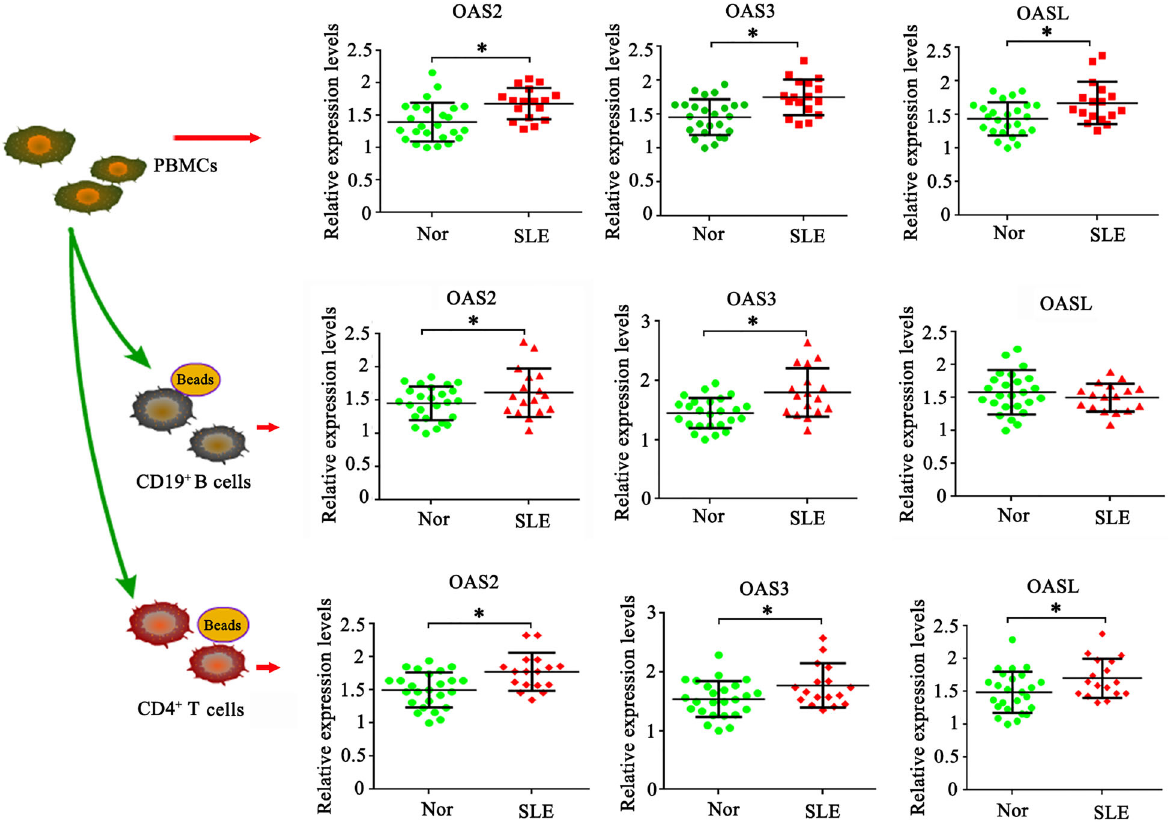
Figure 2. OAS2, OAS3, and OASL were up-regulated in immune cells in systemic lupus erythematosus (SLE) patients. PCR assay was performed to evaluate OAS2, OAS3, and OASL expression in peripheral blood mononuclear cells (PBMCs), CD19 + B cells, and CD4 + T cells in patients with SLE and healthy participants (Nor). Horizontal lines indicate median and interquartile range. *P o 0.05 vs Nor (Student ’ s t